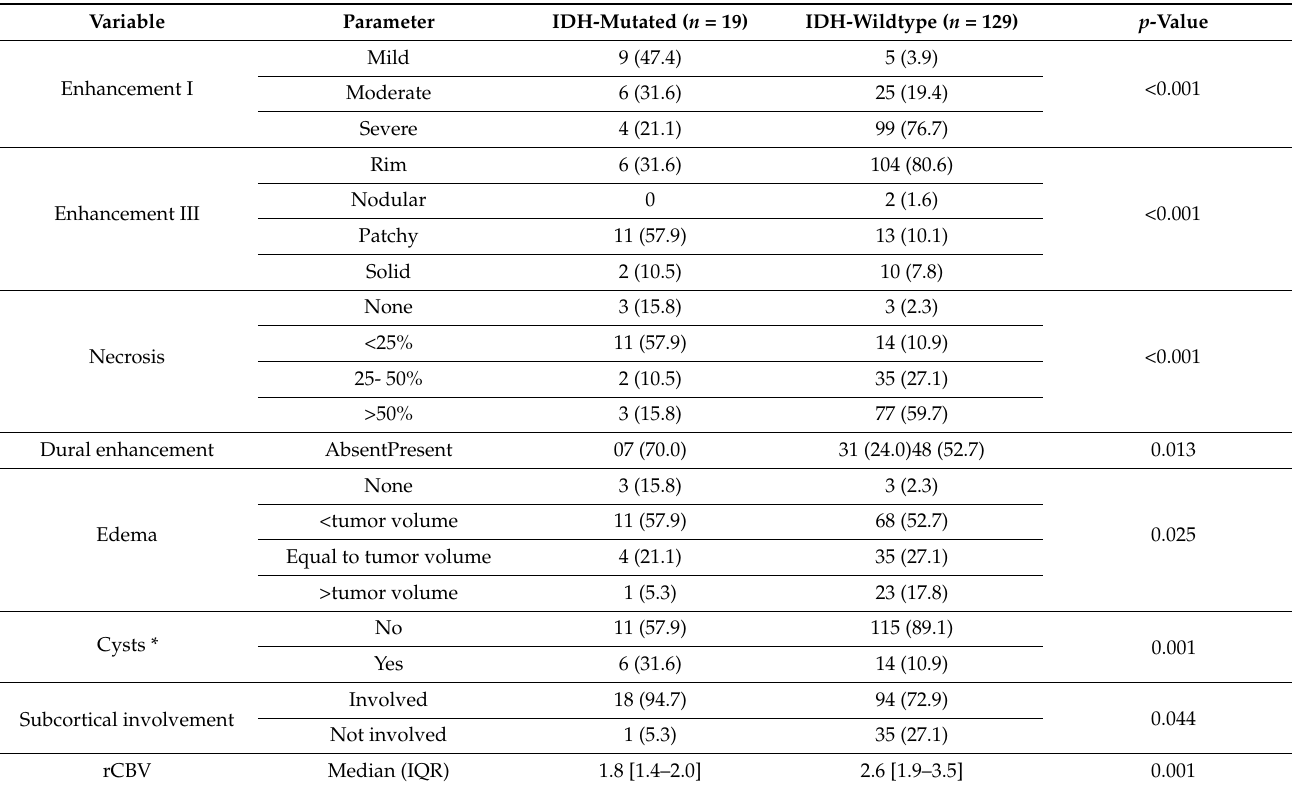
Table 2. Univariate analysis of MRI imaging correlates of IDH status.